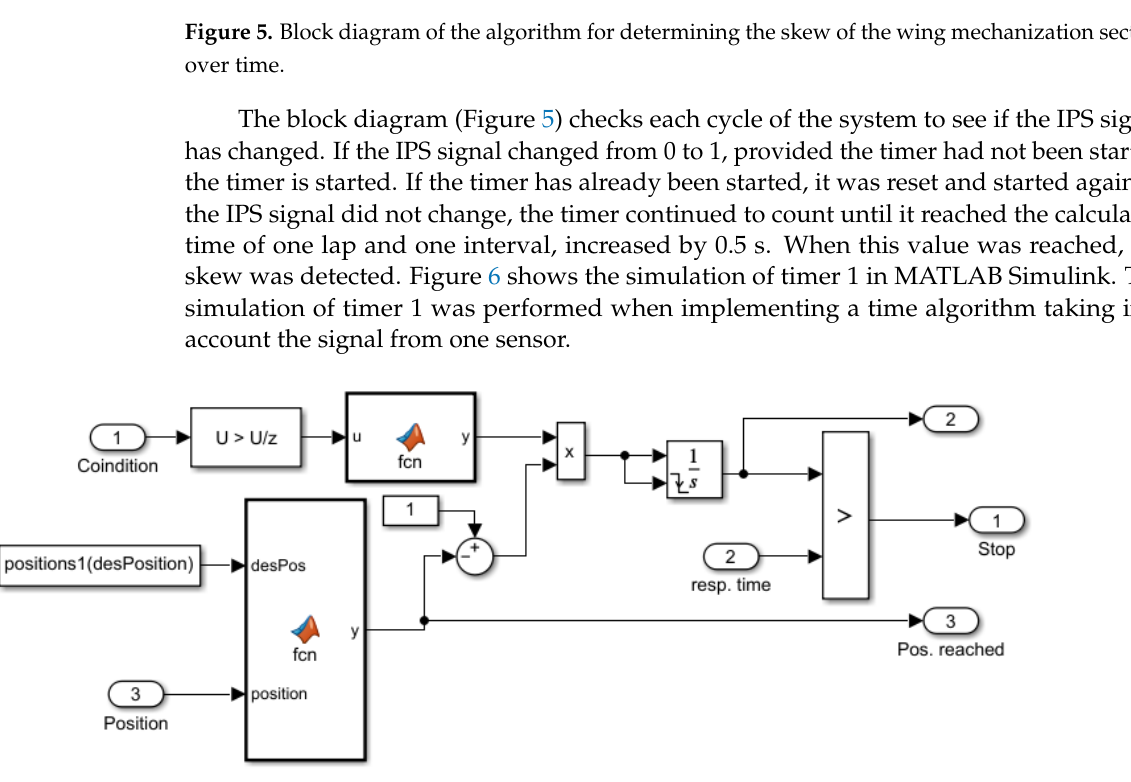
Figure 6. Implementation of signal control from one IPS when implementing the time algorithm (timer